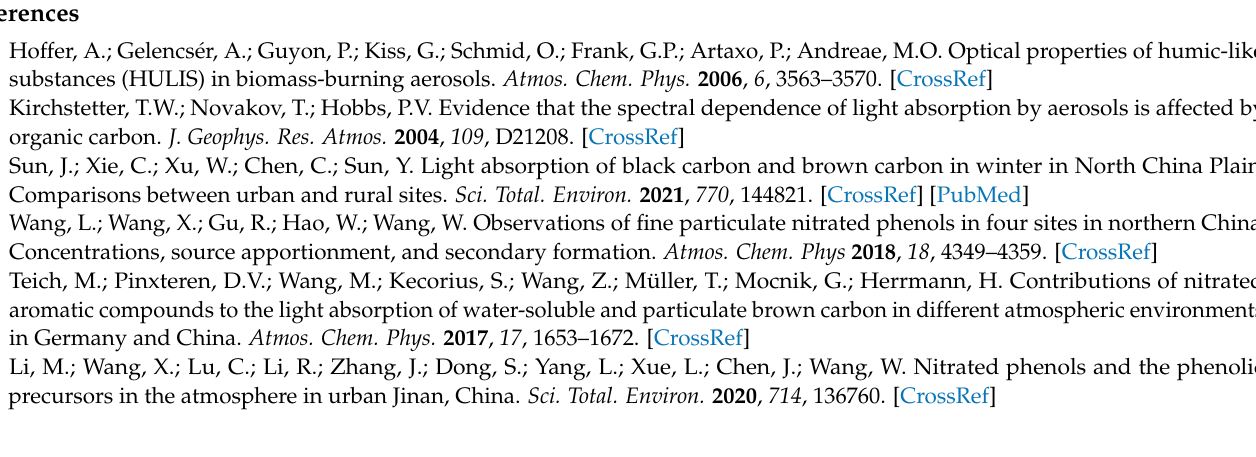
Table S2: Delivered energy-based EFs (average ± standard deviation, mg MJ − 1 ) of phenolics and nitrated phenols in PM2.5, TSP and gas phase; Table S3: PM EFs, MCE, TE and Cad(bot) for tested coal samples; Table S4: Optical characteristics and OC concentration for PM2.5 in flue gas from different coal combustion; Table S5: EFs of NOx, SO2, CO and CO2 for tested coal samples; Table S6: EFs of Na, Al, and Si in PM2.5 for different coal samples; Table S7: Received mass-based EFs (average ± standard deviation, mg kg − 1 ) of phenolics and nitrated phenols in PM2.5, TSP and gas